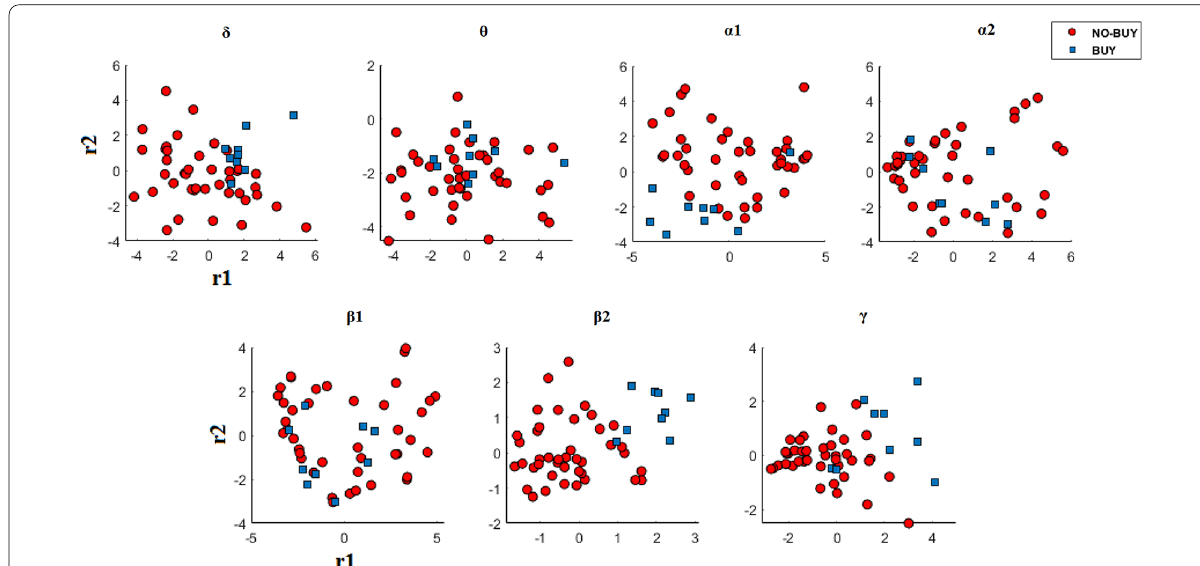
Fig. 3 Brain rhythm-dependent semantic geodesic maps [38] of the single-trial covariance patterns relating to static advertisements in case of subject